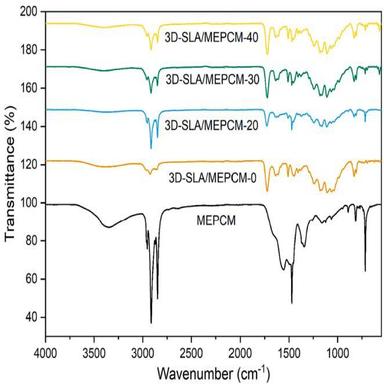
FTIR spectra of MEPCM reinforcement material, resin matrix, and 3D-SLA/MEPCM composites.